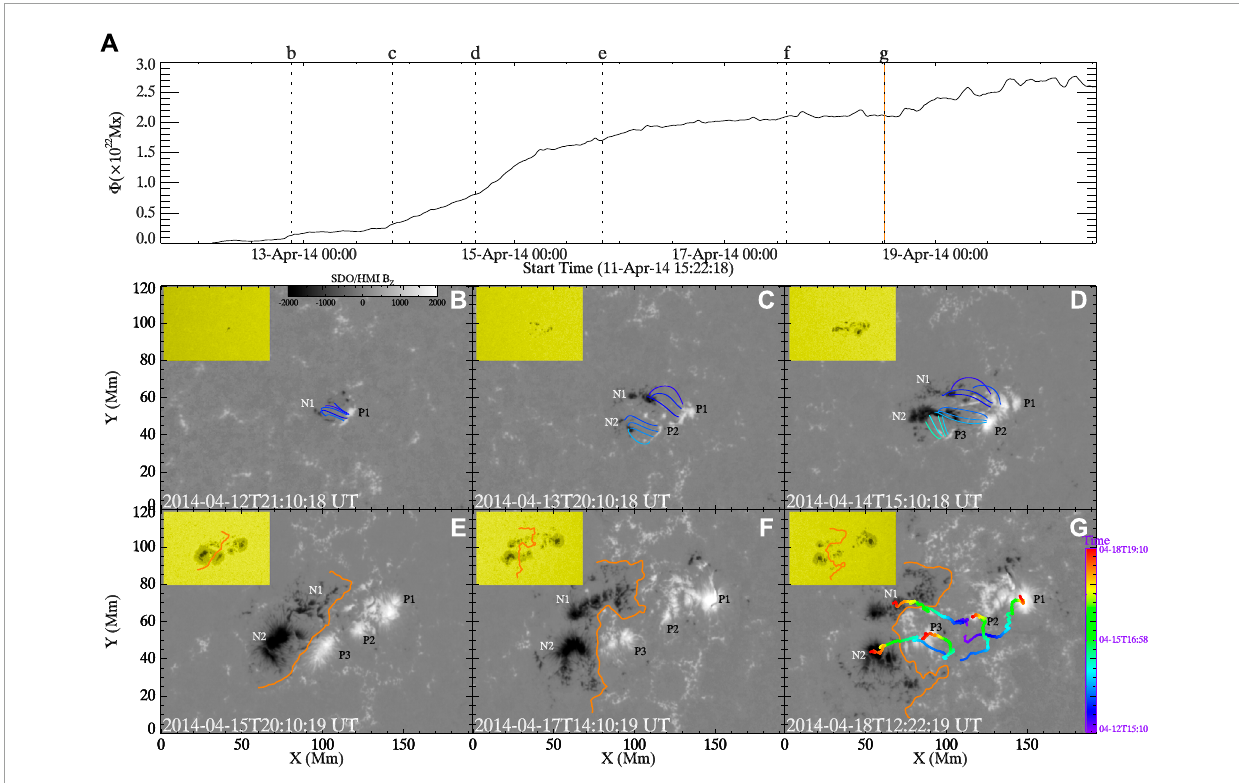
FIGURE 2 Overall evolution of the AR. (A) Unsigned magnetic flux Φ of the AR. The vertical-dashed lines indicate the times of panels. (B–G) The orange vertical line marks the start time of the M7.3-class flare. Snapshots of the photospheric B z showing the evolution of the AR. The insets in each panel show the photospheric continuum intensity at the same time as B z maps. The labels “P1,” “N1,” “P2,” “N2,” and “P3” mark different polarities. The colored lines in panels (B–G) are the coronal field lines extracted from the potential field extrapolation, showing the connectivity of different polarities in their early emergence phase. The colored curves in panel (G) show the trajectories of the centroids of each polarity, of which the color is coded by the elapsed time. The orange curves in (E–G) are the source PIL extracted on magnetograms at different times. An associated animation ( Supplementary Video S1 ) is available